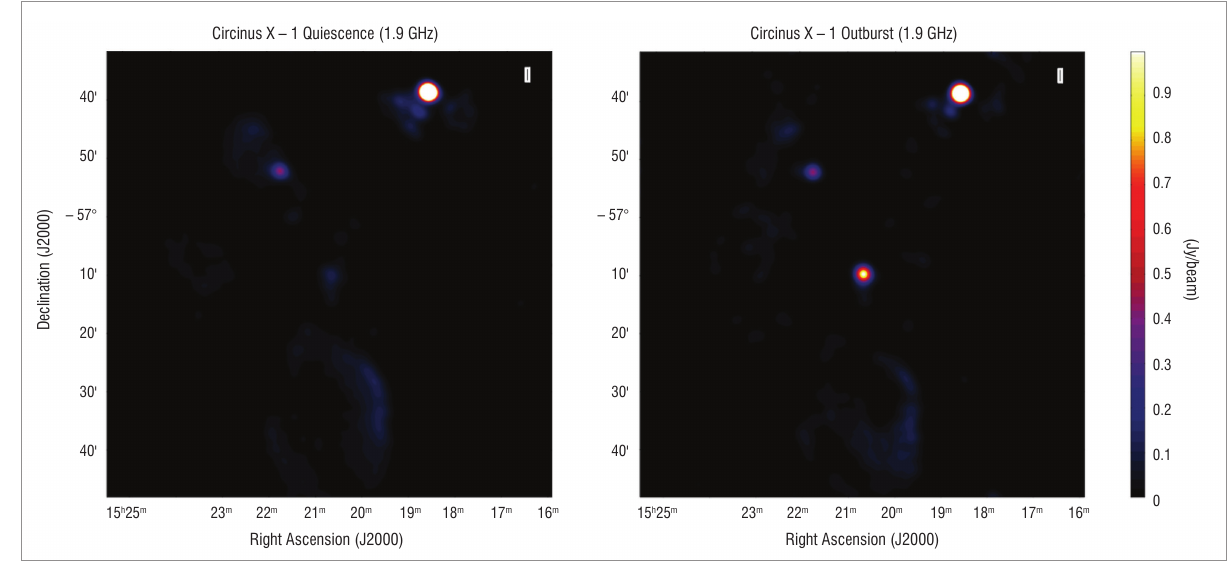
Figure 1 : Variable radio emission from Circinus X-1 in images from the KAT-7 interferometer. The left panel shows a fiducial profile image obtained during the quiescent phase of the binary flare cycle averaged over a 10-day period. Circinus X-1 is located at the centre of the field. The right panel shows an image taken during the radio flaring phase (23 December 2011) for N3109 – Antlia Dwarf – Background Galaxies: DSS+HI Mosaic